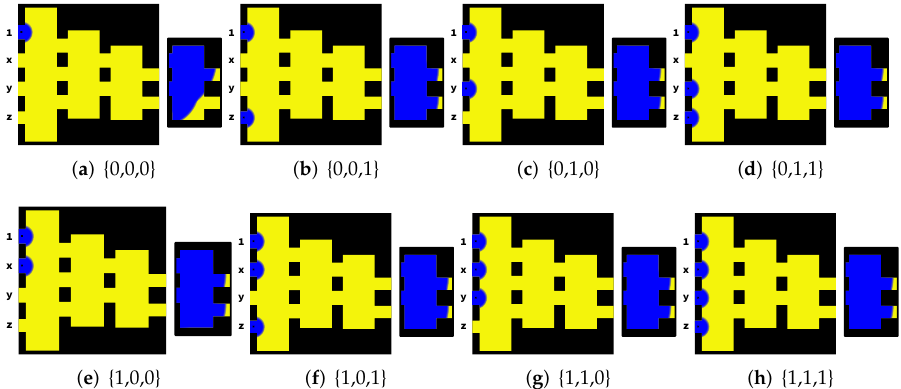
Figure 16. Example of a 3-input OR gate chemical topology. Input ( left ) and result ( right ) time frames for each possible input { x , y , z } .